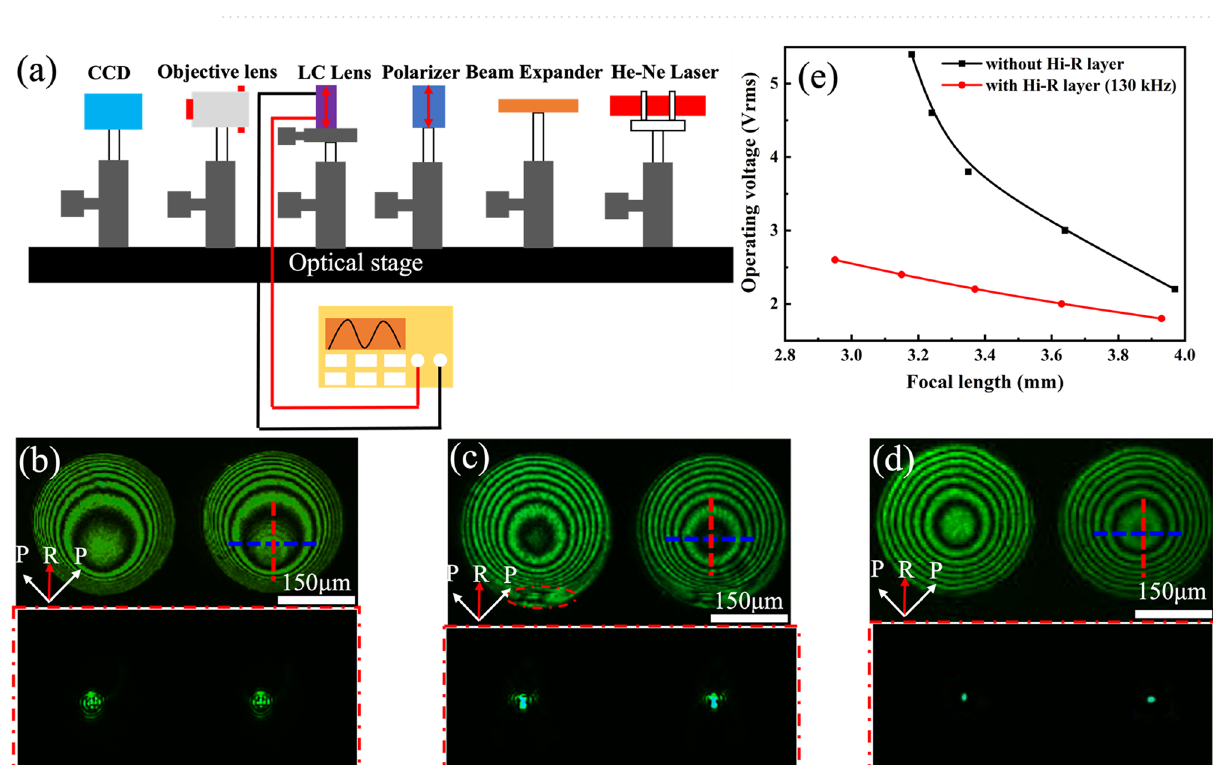
Figure 2. ( a ) The testing system for measuring the electro-optical properties of the LC MLAs; Optical properties of LC MLAs without Hi-R layer at ( b ) 2.2 V rms and ( c ) 3.8 V rms ; ( d ) Optical properties of Hi-R LC MLAs at 2.2 V rms with driving frequency of 130 kHz; and ( e ) Focal length-dependent the working voltage for the different LC